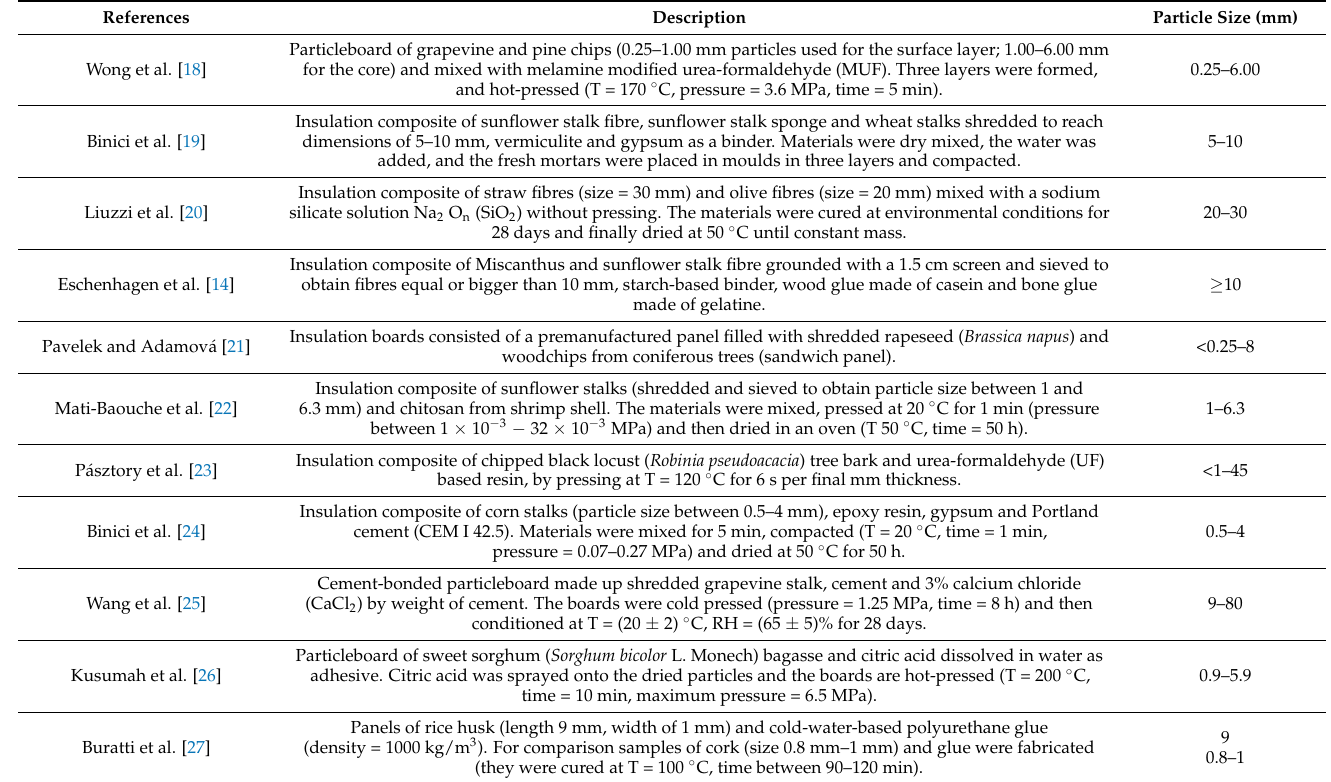
Table 1. Particle size of bio-aggregates already studied for boards’